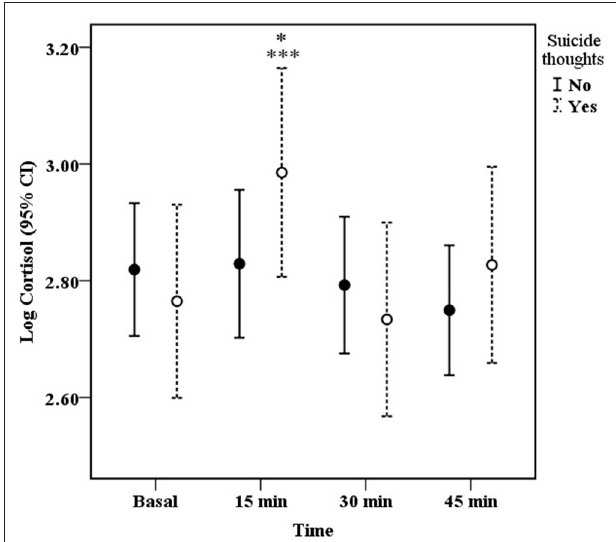
FIGURE 2 | Mean ( ± 95% CI) of salivary cortisol concentration before (basal), and 15, 30, 45min after the onset of the cognitive test in IPV exposed women with ( N = 29) and without ( N = 42) suicide thoughts. Suicide thoughts: *** P < 0.001 vs. 30min, * P < 0.05 vs. basal.